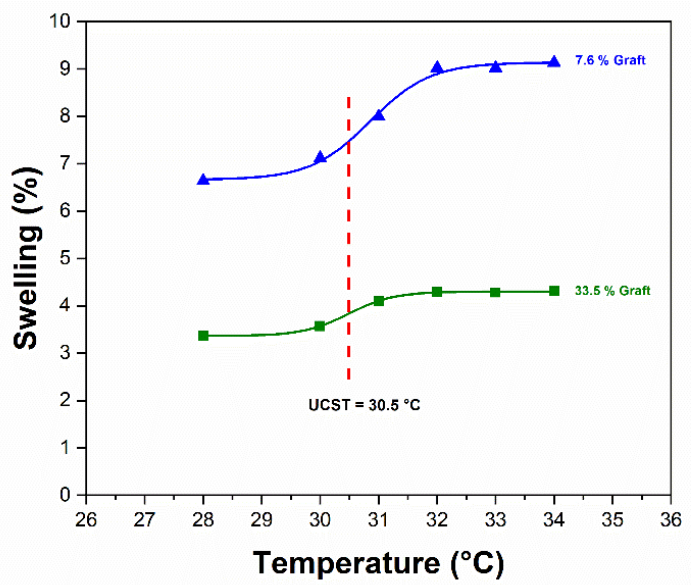
Figure 7. Temperature response by swelling of (SR- g -PNVCL)- g -P2MBA films.